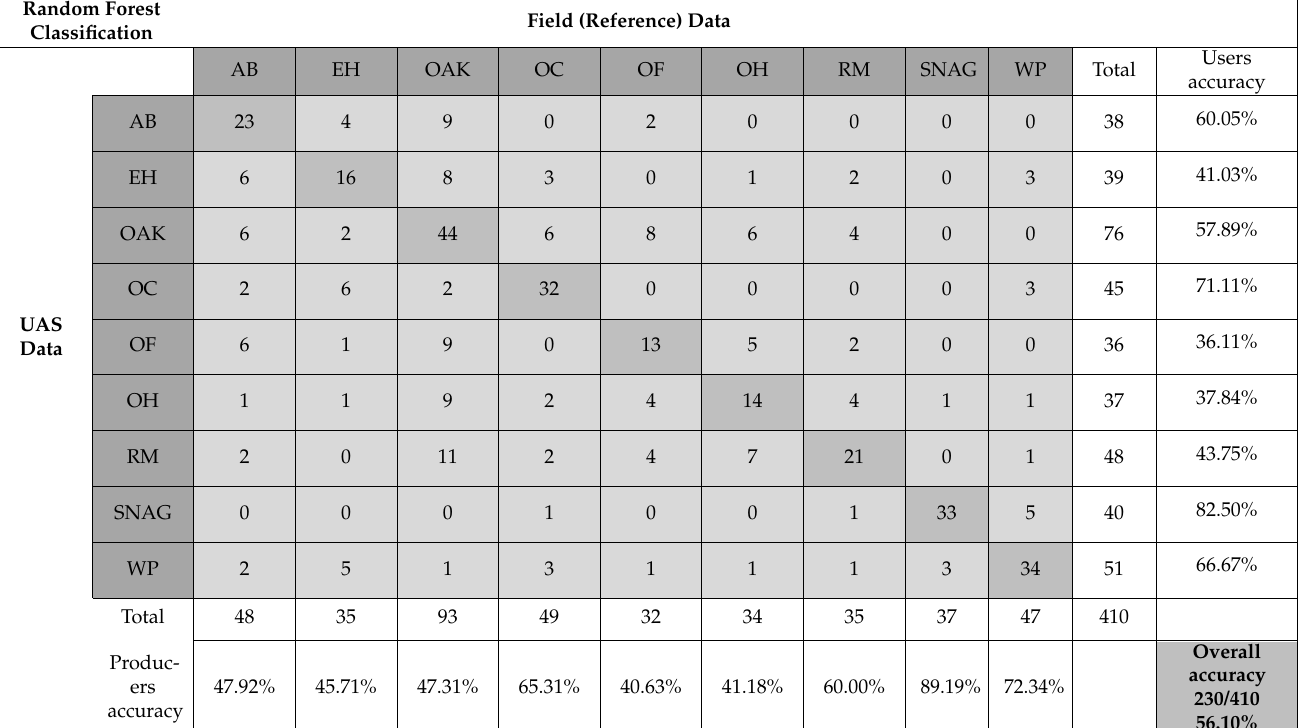
Table 4. Species-based classification thematic map error matrix conducted on nine species: American beech (AB), eastern hemlock (EH), oaks, other conifers (OC), other forests (OF), other hardwoods (OH), red maple (RM), snags, and white pine (WP). Classification was completed using the random forest (RF) supervised classification